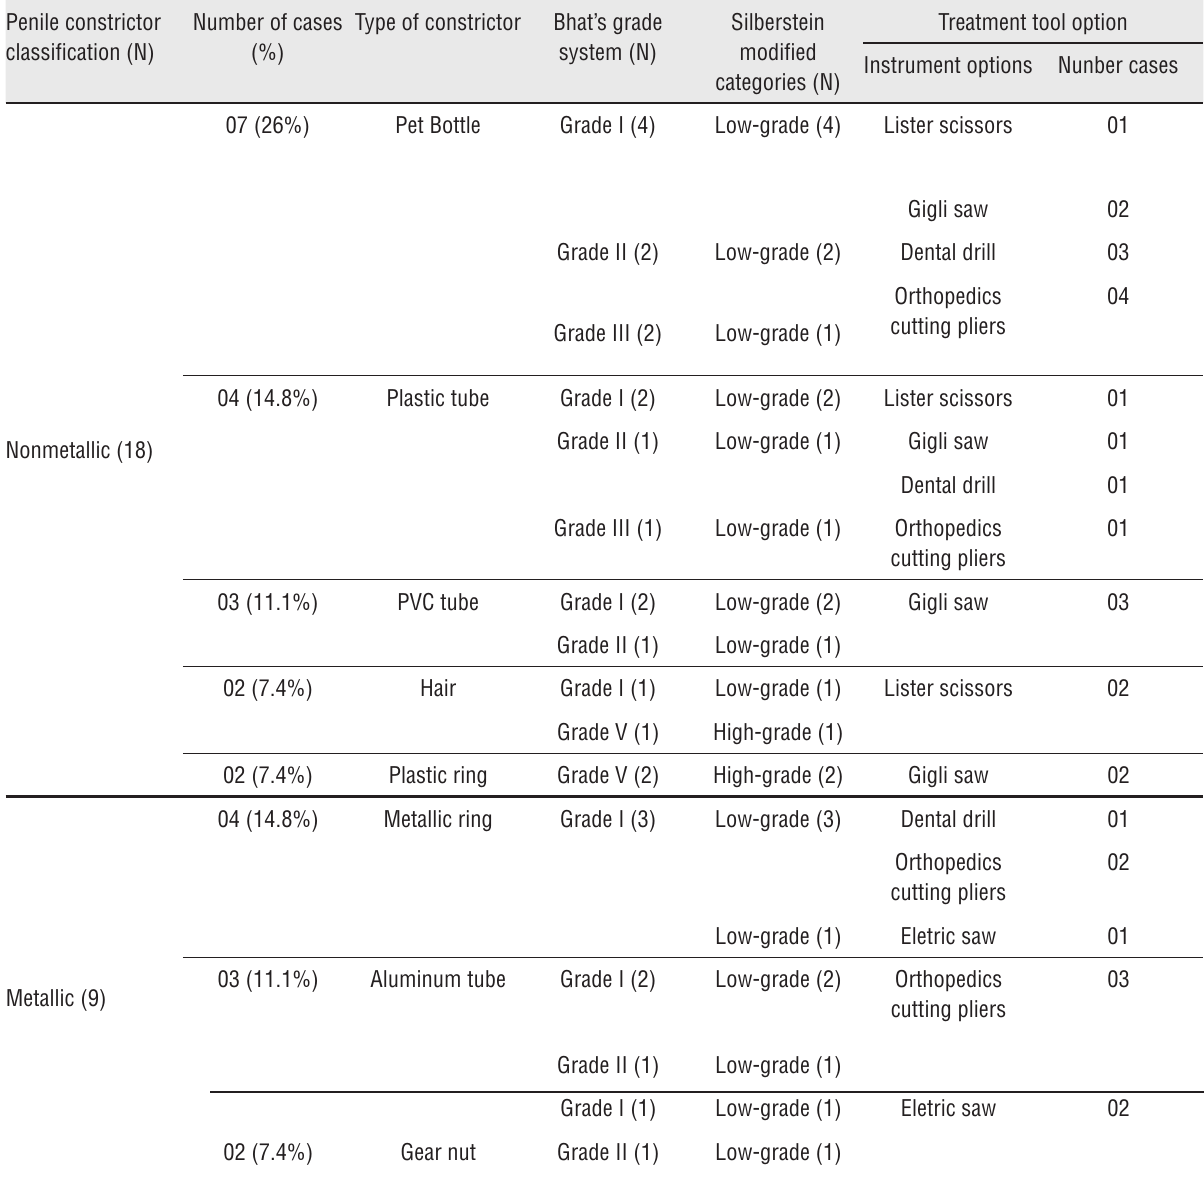
Table 1 - Treatment options for penile entrapment according to penile constrictor device and constriction injuries classification according to Bhat grading system and Sylberstein modified